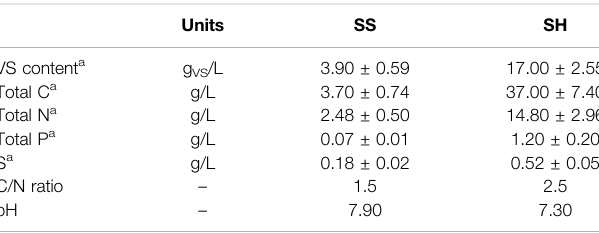
TABLE 2 | Characterization of the substrates studied in the preliminary